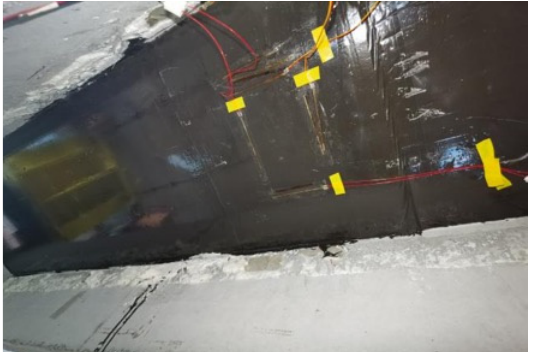
Figure 19. The reinforcement layer at the slab bottom of the reinforced P3 after 3 million fatigue cycles.